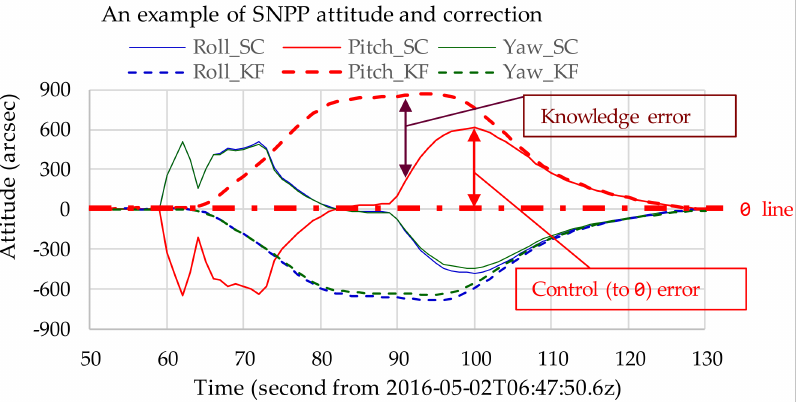
Figure 10. An example of SNPP attitude excursion and definitions of control and knowledge errors. The curves from Kalman filter processing are accurate and the differences are the knowledge